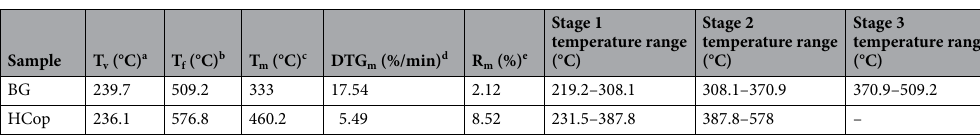
Table 3. Pyrolysis characteristic parameters of BG and the AHCop at heating rate of 10 °C/min . a T v : the initial decomposition temperature. b T f : the terminated temperature. c T m : the maximum decomposition rate temperature. d DTG m is maximum weight loss rate. e R m is final mass